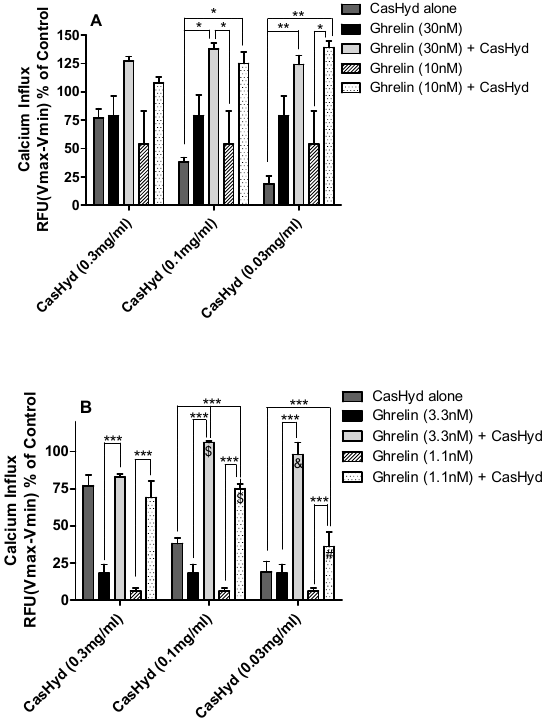
Figure 6. Additive and synergistic effects of GHS-R1a activation following co-treatment of ghrelin and CasHyd. Additive and synergistic effects are observed following co-treatment of HEK cells stably expressing the GHS-R1a with hydrolysate and 30 nM or 10 nM ghrelin ( A ), or hydrolysate and 3.3 nM or 1.1 nM ghrelin ( B ). Intracellular calcium increase was normalised to the maximum calcium increase as elicited by control (100 nM ghrelin). Graphs represent the mean ± SEM of a representative experiment of three independent experiments, with each concentration point performed in triplicate. Statistically significant differences of combination treatment indicating an additive effect were calculated using a one-way analysis of variance (ANOVA) followed by the Bonferroni post-hoc test for multiple comparisons and are depicted as *** p < 0.001, ** p <0.01 and * p <0.05. Statistically significant differences of a synergistic effect are depicted as; $ p < 0.001, & p < 0.01 and # p <